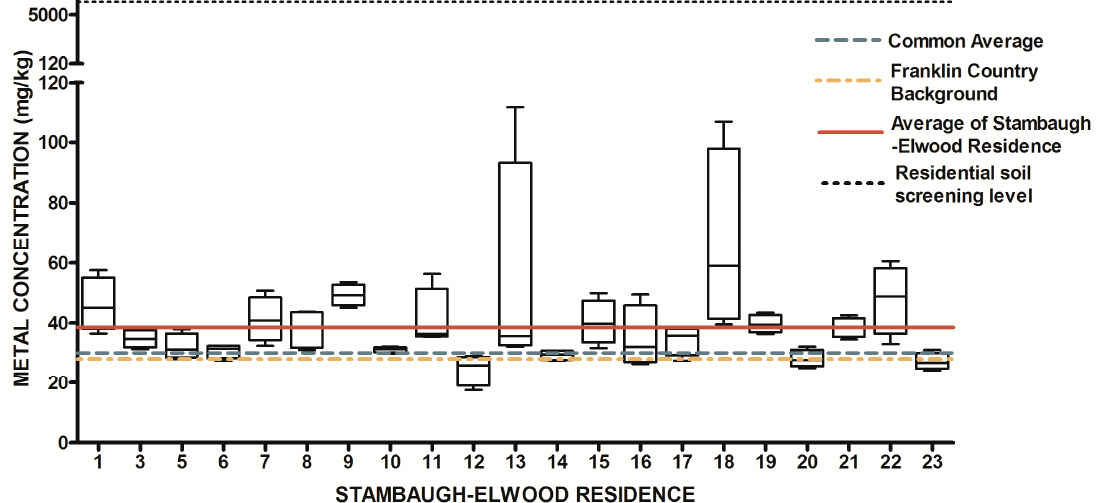
Figure 8. Residential urban soil level of Cu in the Stambaugh-Elwood community versus Franklin County (background), common averages and residential screening levels (RSLs) (mg/kg soil). Soil samples were taken from 21 of 46 residences that consented for the study in compliance with OSU